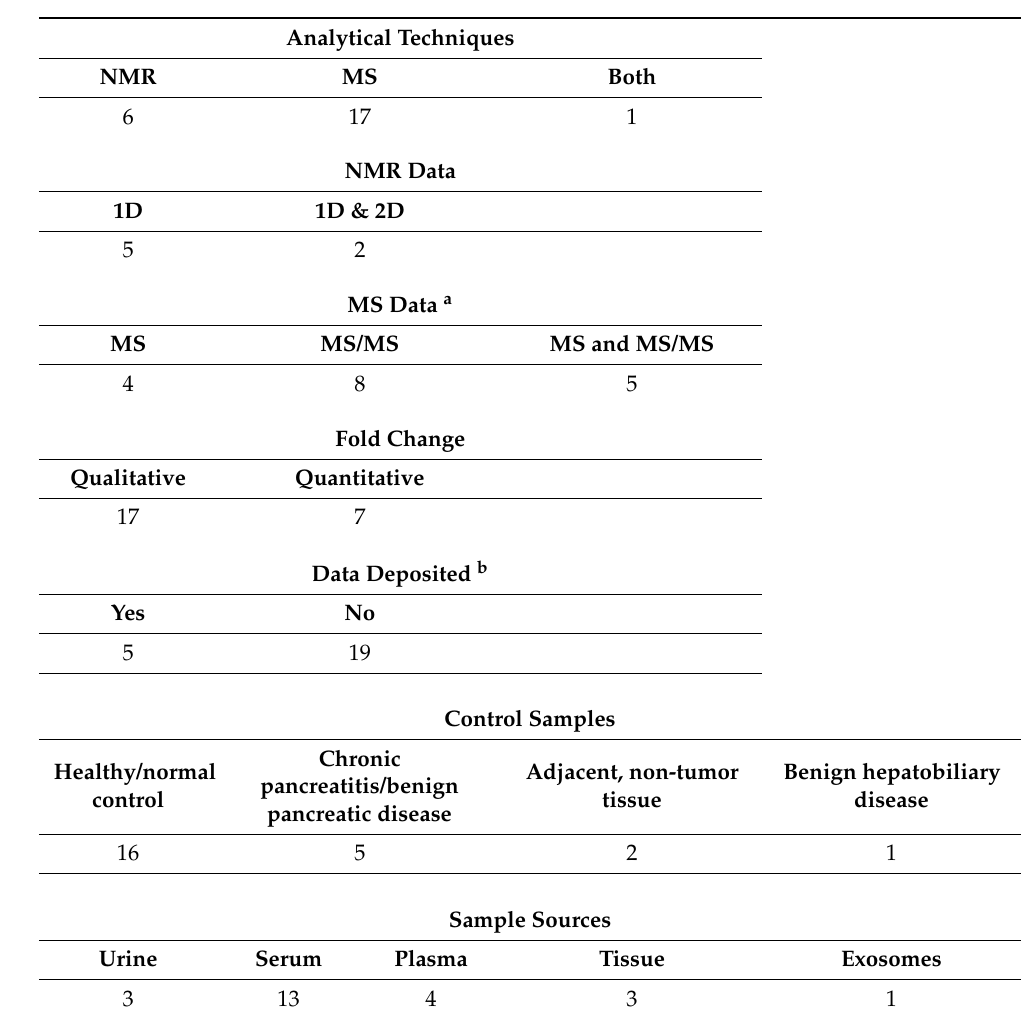
Table 2. Summary of Study Designs from the 24 PDAC